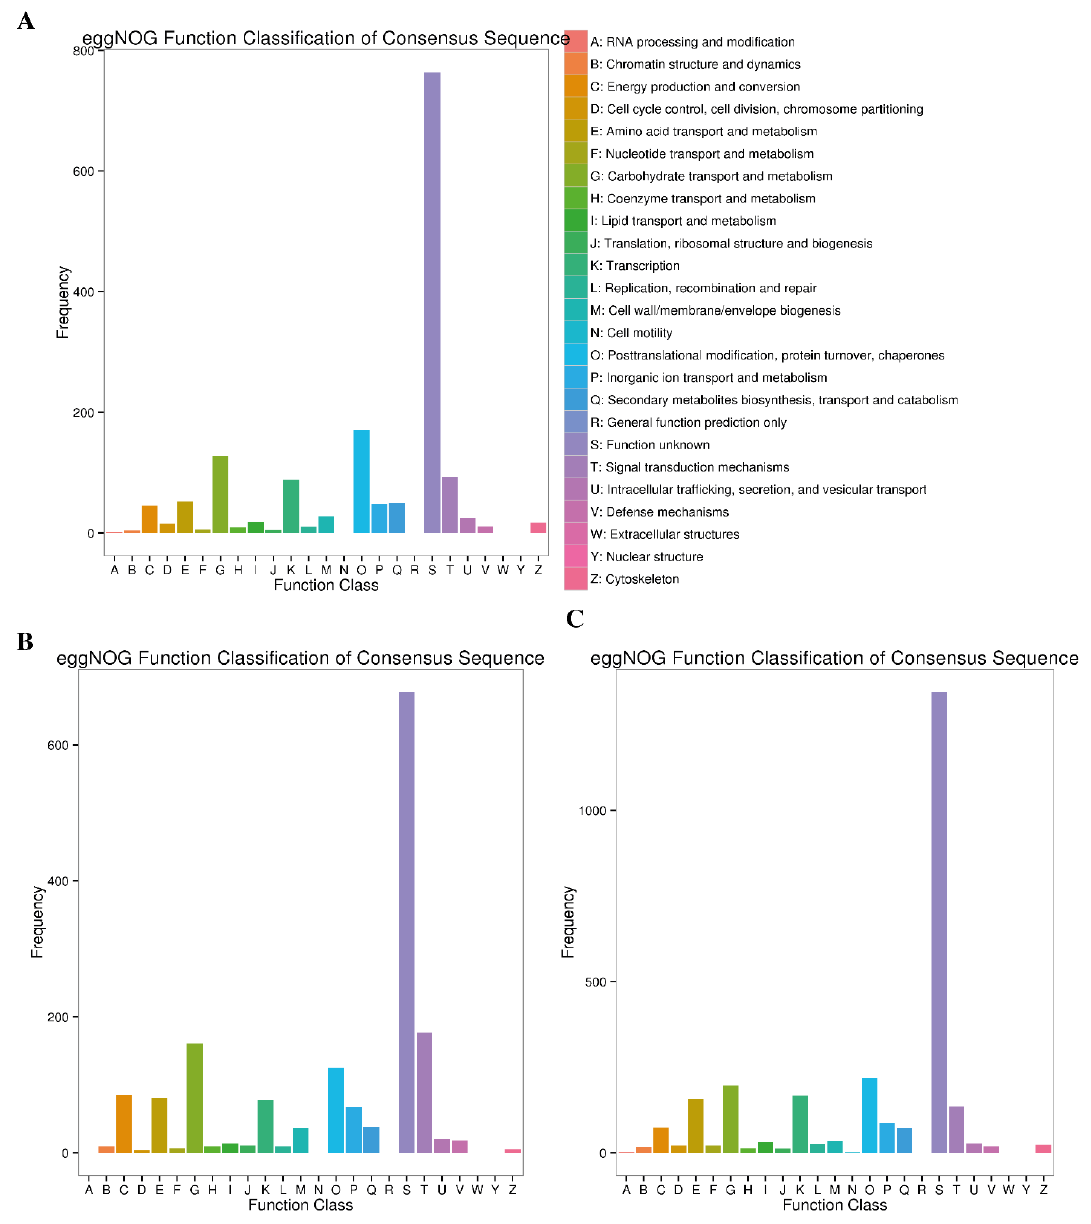
Figure 8. eggNOG pathway annotation of DEGs at three comparative stages under Cd stress. ( A ) at 7d of Cd stress; ( B ) at 14d of Cd stress and ( C ) at 30d of Cd stress.